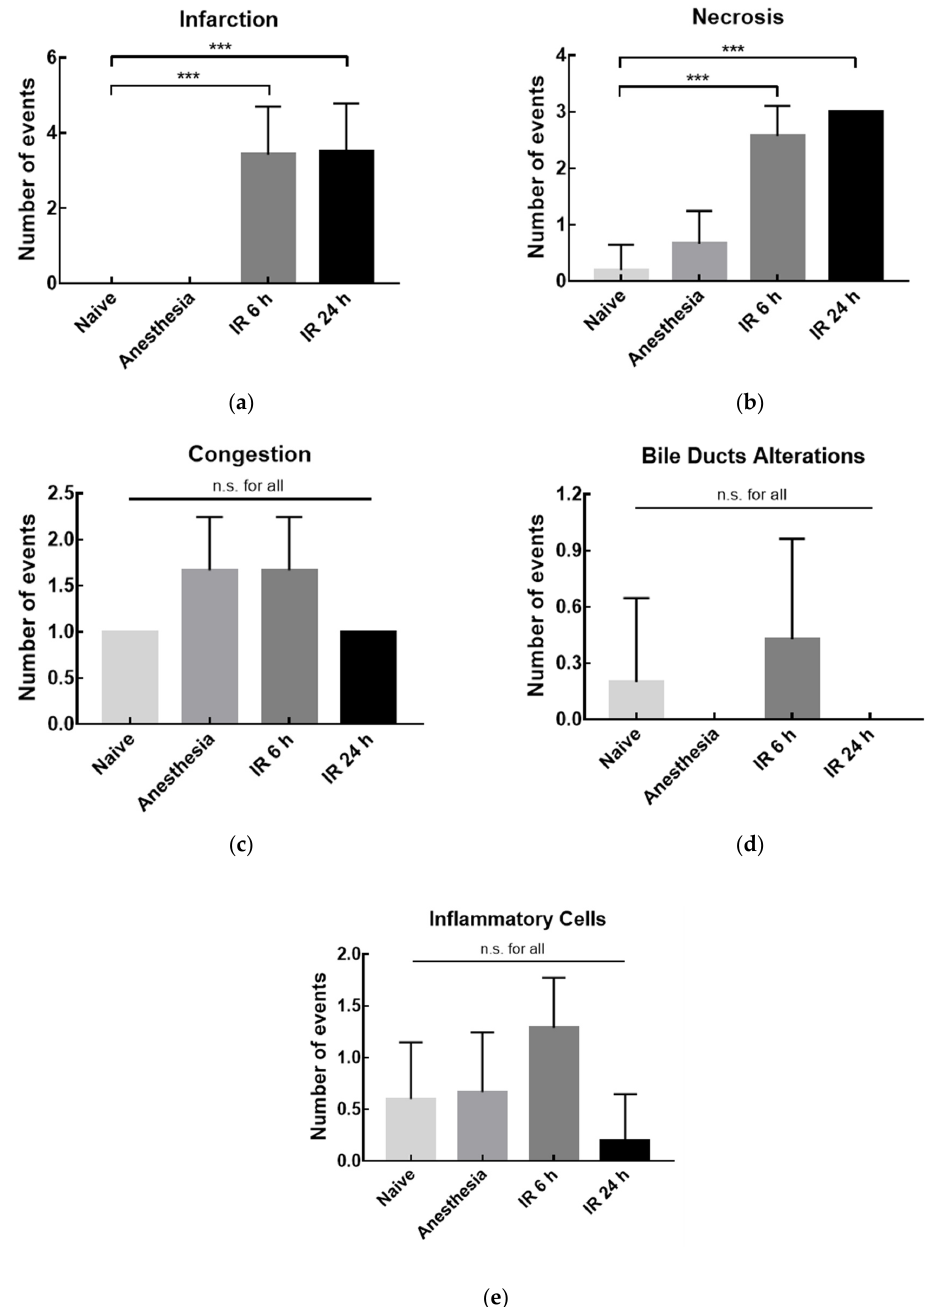
Figure 11. Histochemical analysis of the number of events for rats’ liver from naïve, sham anesthesia, or IR group. Rats were sacrificed 6 h (IR 6 h) or 24 h (IR 24 h) after the reperfusion onset and damage—( a ) infarction; ( b ) necrosis, and ( c ) congestion—or recovery—( d ) bile ducts alterations and ( e ) presence of inflammatory cells—indicators were evaluated. Number of events: 0, absence; number, number of detected events. Results are presented as mean ± SD ( n = 4). *** p < 0.001 compared with naive group; n.s., statistically non-significant compared with naive group.